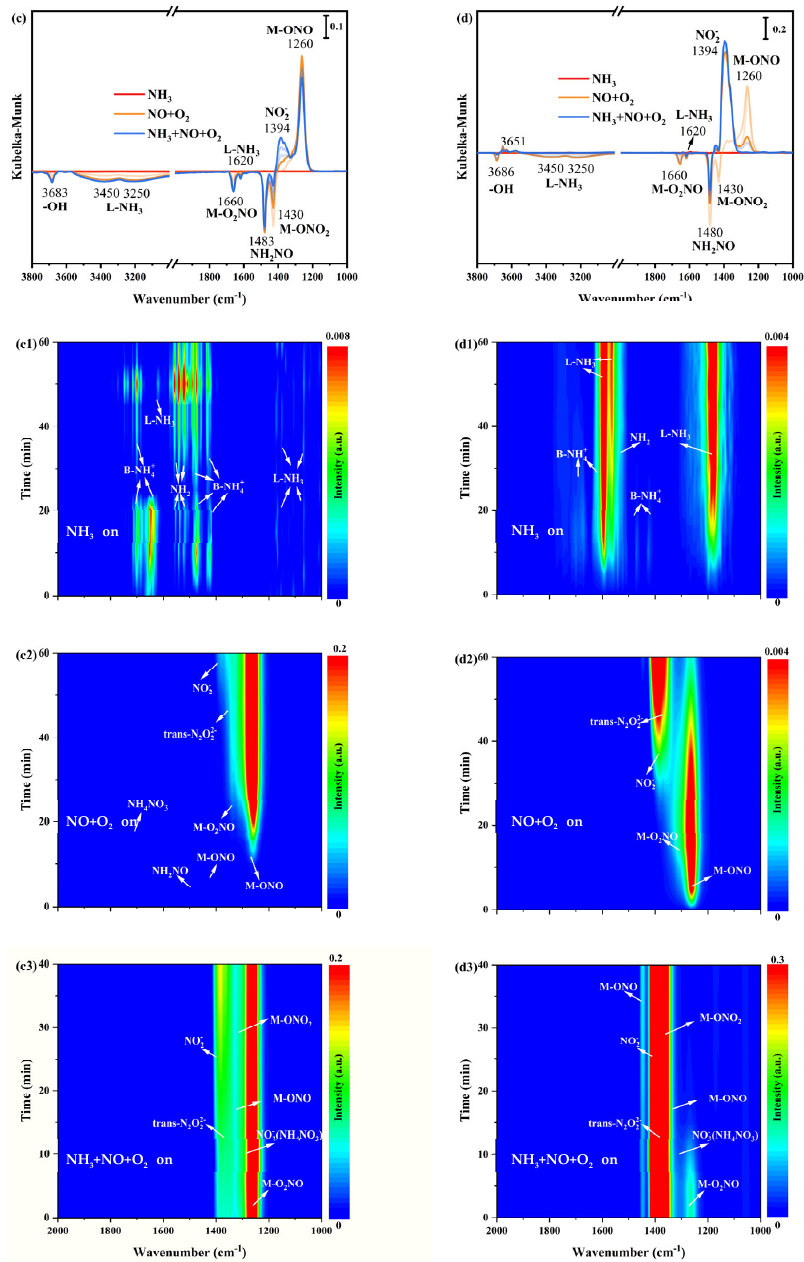
Figure 5. In situ DRIFTS spectra of NH 3 adsorption at 200 °C over ( a1 ) α -MnO 2 /X, ( b1 ) β -MnO 2 /X, ( c1 ) γ -MnO 2 /X, and ( d1 ) σ -MnO 2 /X catalysts; in situ DRIFTS spectra of NO+O 2 reacted with pre- adsorbed NH 3 species at 200 °C over ( a2 ) α -MnO 2 /X, ( b2 ) β -MnO 2 /X, ( c2 ) γ -MnO 2 /X, and ( d2 ) σ -MnO 2 /X catalysts; in situ DRIFTS spectra of NH 3 +NO+O 2 species at 200 °C over ( a3 ) α -MnO 2 /X, ( b3 ) β -MnO 2 /X, ( c3 ) γ -MnO 2 /X, and ( d3 ) σ -MnO 2 /X catalysts; the summary of in situ DRIFTS spectra of NH 3 adsorption, NO+O 2 reacted with pre-adsorbed NH 3 species, and NH 3 +NO+O 2 species at 200 °C over ( a ) α -MnO 2 /X, ( b ) β -MnO 2 /X, ( c ) γ -MnO 2 /X, and ( d ) σ -MnO 2 /X catalysts; conditions: 500 ppm NH 3 (when used), 500 ppm NO, 11% O 2 (when used), and N 2 as balance. After NO+O 2 introducing, in situ DRIFTS spectra of reactions between NO+O 2 and pre-adsorbed NH 3 species on catalysts were obtained. In Figure 5a2, the bands’ intensity of the acid sites was weak and hardly found when NO+O 2 was introduced on α -MnO 2 /X catalysts, and then some bands at 1178 cm − 1 , 1394 cm − 1 , 1400 cm − 1 , 1430 cm − 1 , 1460 cm − 1 , and 1660 cm − 1 belonging to bridging nitrate species (M-O 2 NO), nitro species (M-NO 2 ),